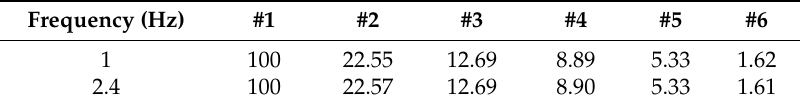
Table 3. Ratios of vibration displacements under different frequencies loads (%).